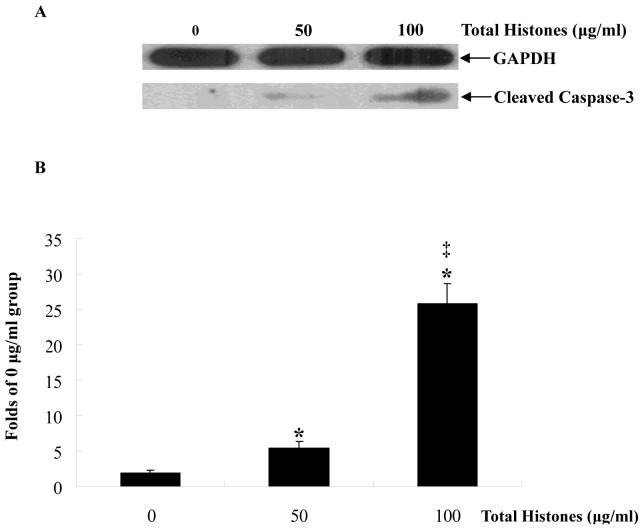
Histones induced caspase 3 activation in a dose-dependent manner.A. Isolated human lymphocytes were exposed to various concentrations (0, 50, 100 µg/ml) of histones. Lymphocyes were harvested 1.5 h after treatment and casepase 3 activation was detected by western blotting. Celeaved caspase 3 represents the activation of caspase 3. GAPDH was used to verify equal gel loading and transblot efficiencies. B. Bar graph of relative activated caspase 3 intensity. Values are presented as means ± SD (n = 3). *P<0.05, as compared with 0 µg/ml. ‡P<0.05, as compared with 50 µg/ml group.